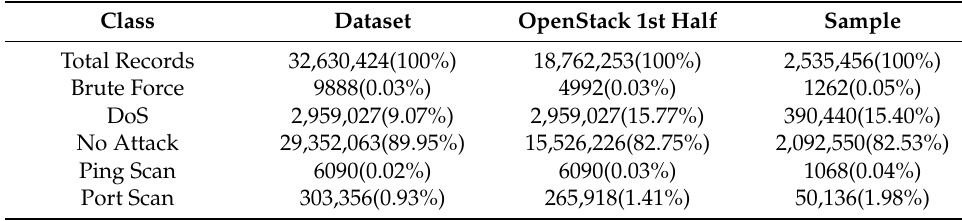
Table 3. AttackType class distribution